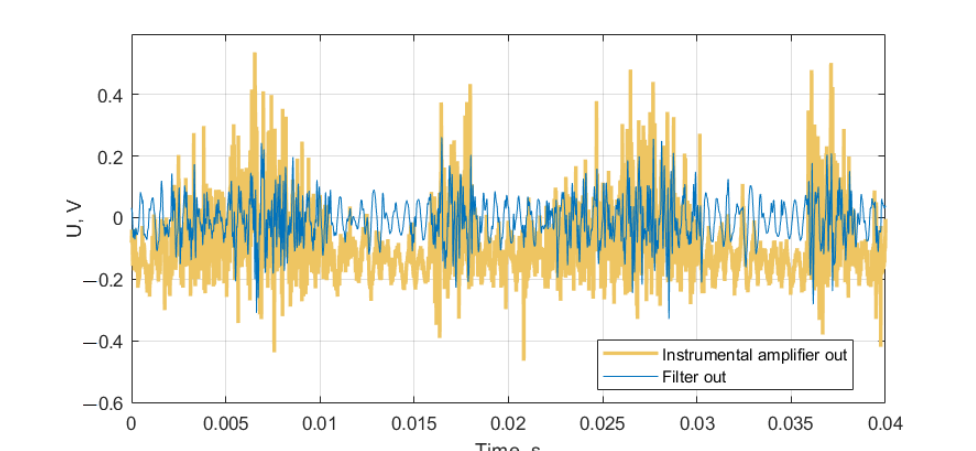
Figure 16. Signal of differential amplifier unit in the absence of the metal object: output signals of two stages are presented.